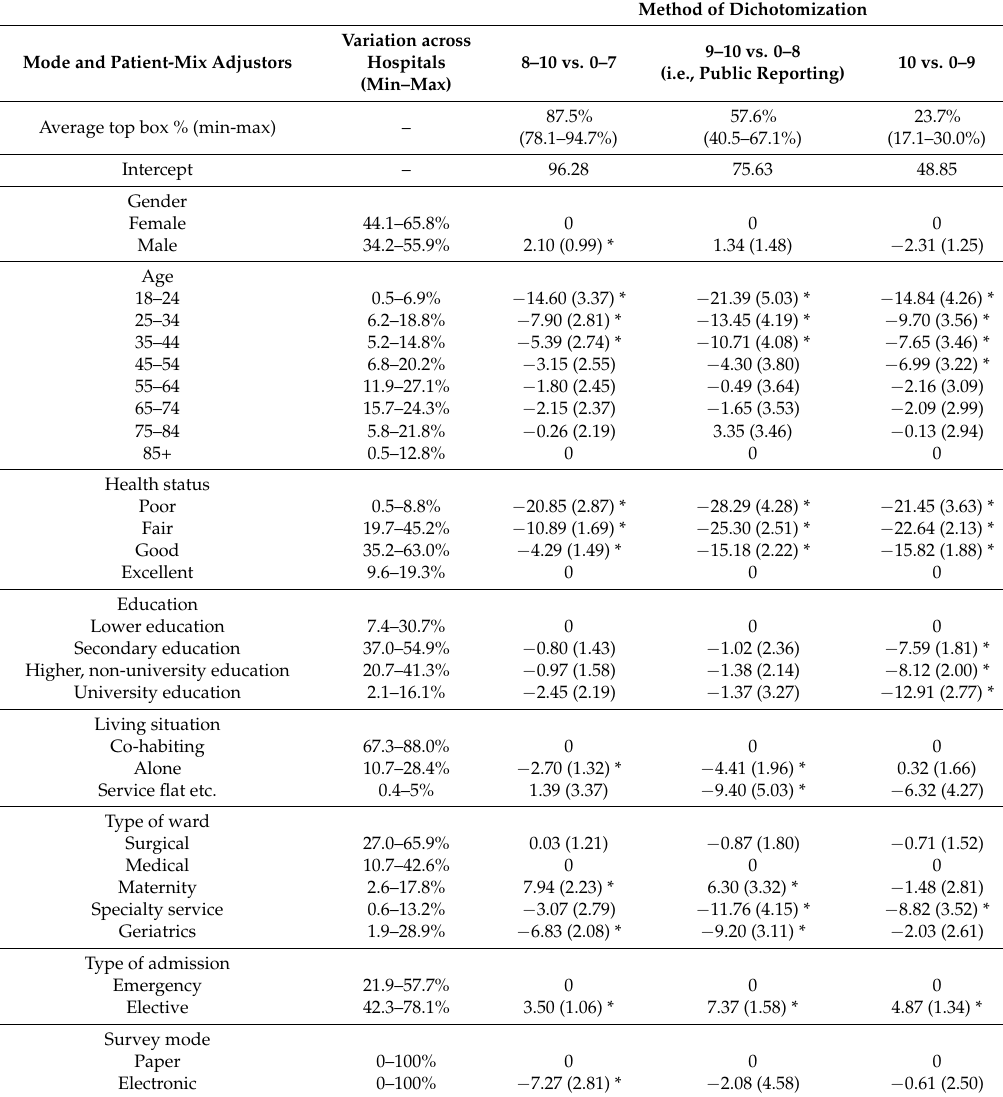
Table 4. Mode and patient-mix adjustment to top category